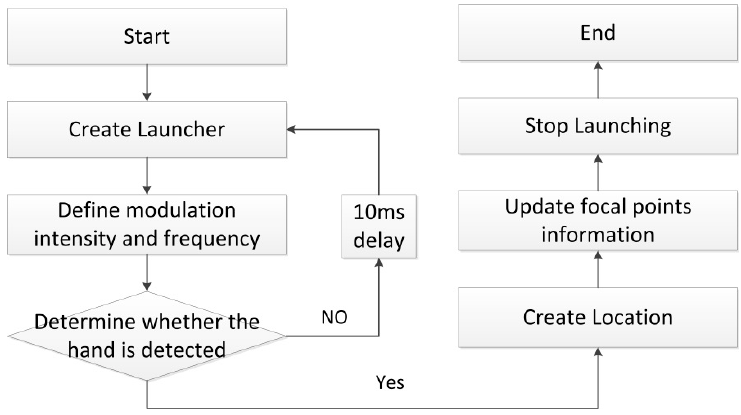
Figure 2. The flow chart of tactile points